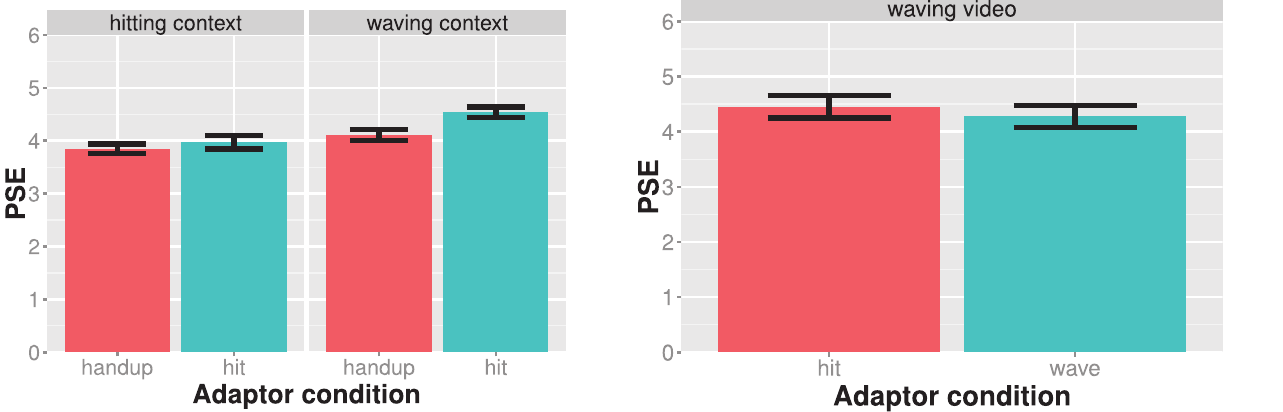
Figure 4. Results of experiment 2. The average PSE is shown for each adaptor condition separately. Larger PSE values indicate that the test stimulus showed more of a hitting action. Bars always indicate one standard error of the